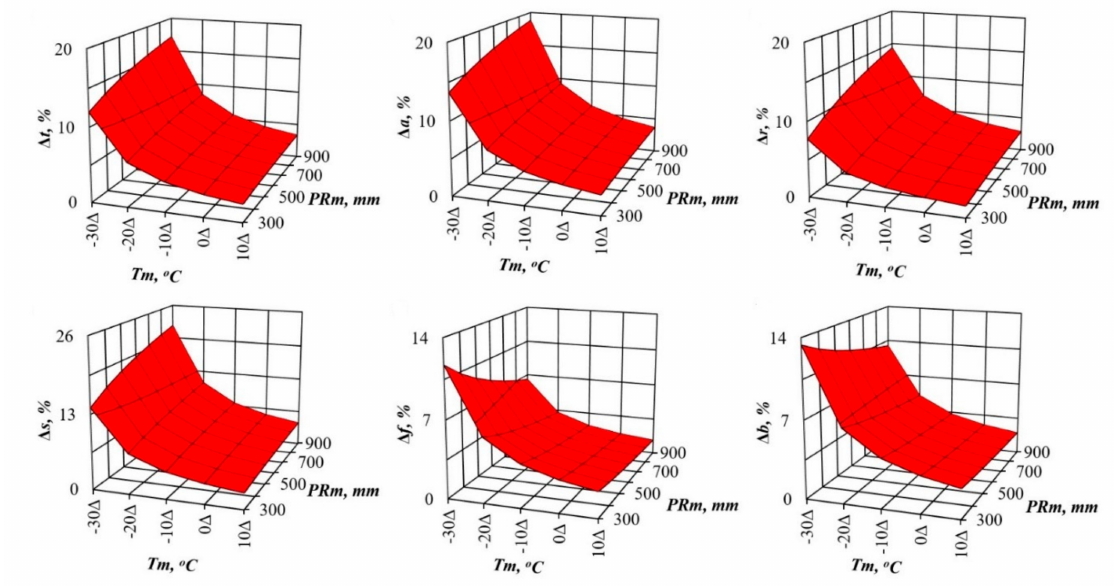
Figure 6. The theoretical changes in spruce biomass in relation to the assumed warming increase of 1 ◦ C based on the model (1) for the stands aged 100 years. Designations: ∆ t , ∆ a , ∆ r , ∆ s , ∆ f and ∆ b are percentages of the biomass of total (above- and underground) wood storey, aboveground storey, underground storey (roots), stems (wood and bark), foliage and branches correspondingly, with a temperature increase of 1 ◦